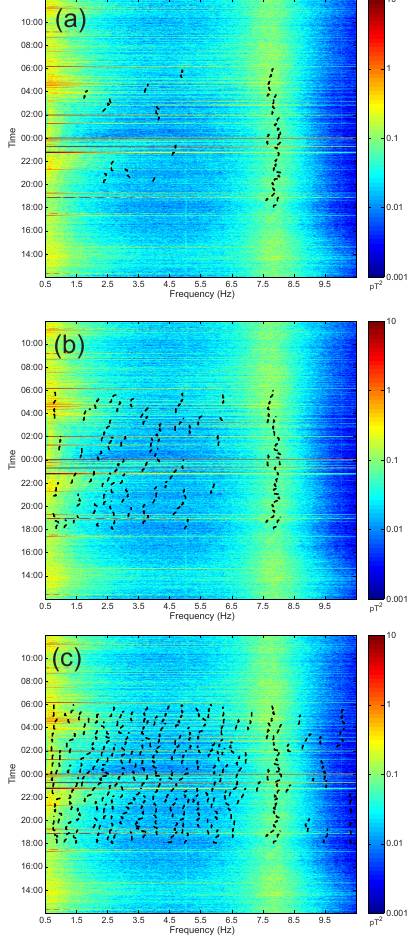
Figure 8. Example spectrogram 13–14 June 2013 with differ- ent threshold values used in the peak finding algorithm: (a) 0.5; (b) 0.25; (c) 0.1. See text for